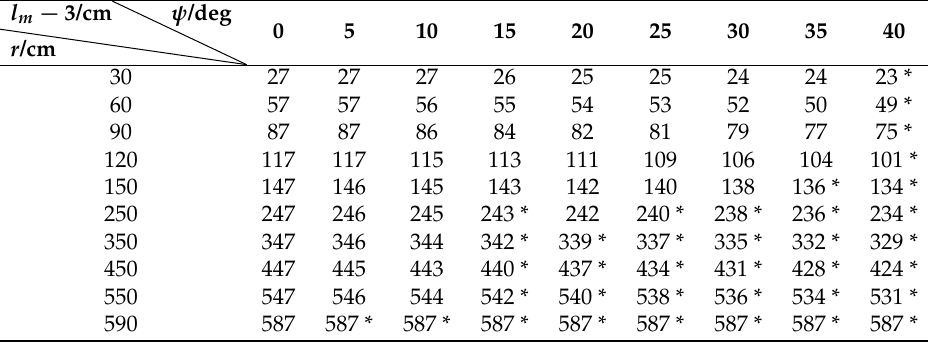
Table 3. Outputs of multi-ray model at various angles and distances.